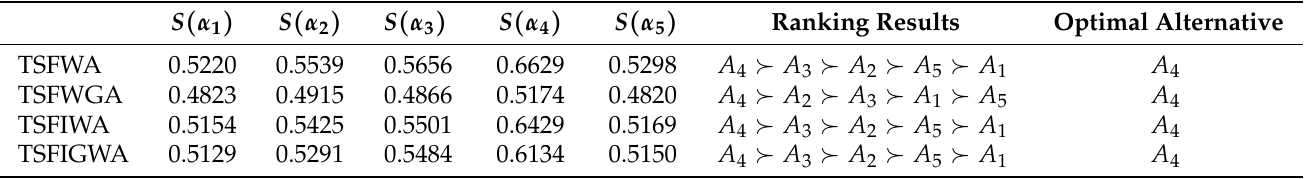
Table 12. Ranking results of different